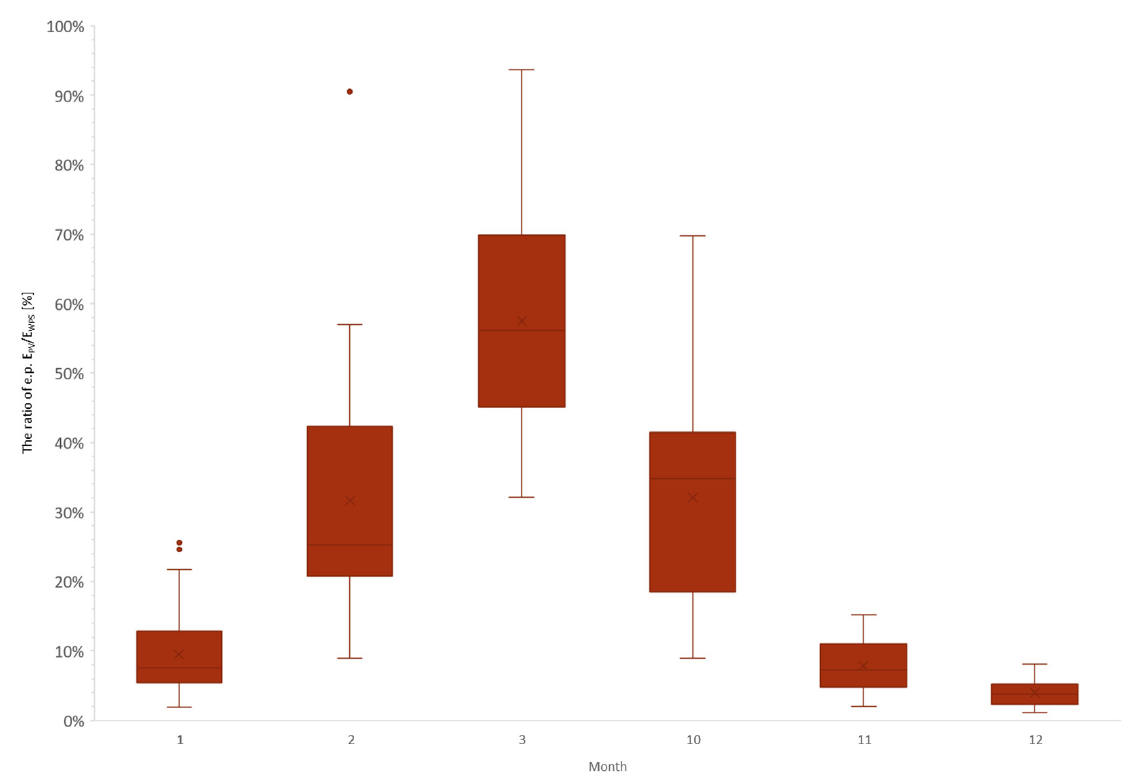
Figure 7. The ratio of electricity production (e.p.) from the PV installation (E PV ) to electricity consumption by the water-pumping station (E WPS ) in months with coverage below 100% (the dots - outliers and x - mean).